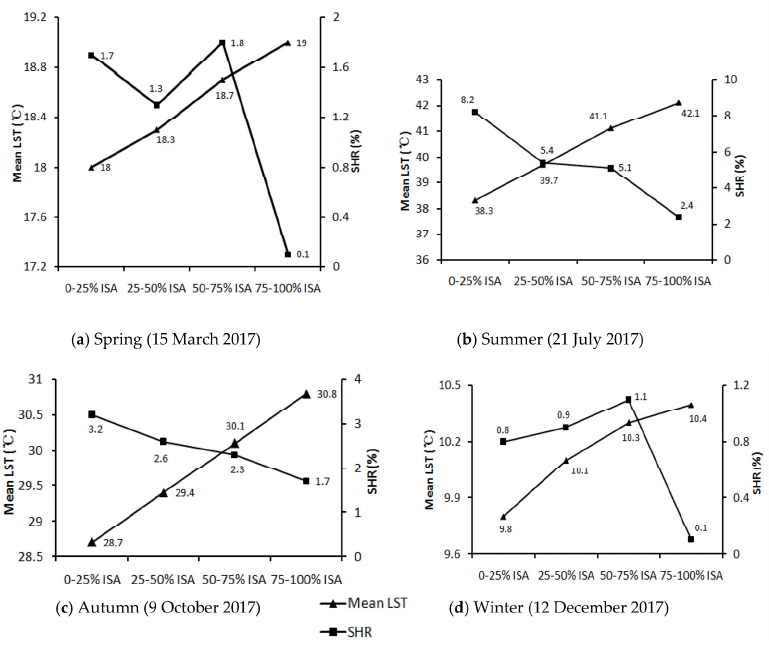
Figure 5. The mean LST and SHR for different percent ISA categories in the four seasons.